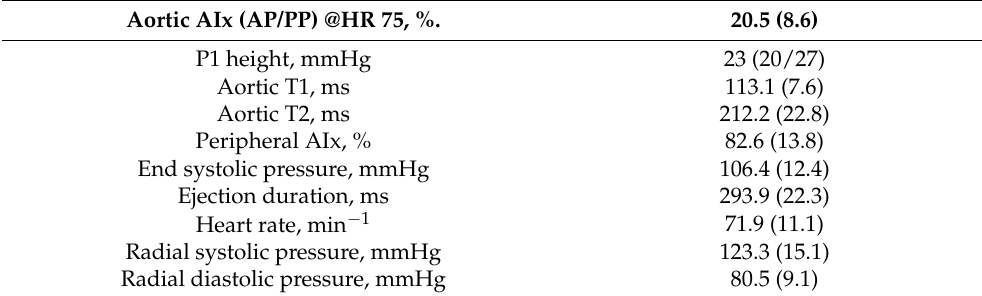
Table 2. Pulse wave analysis parameters.